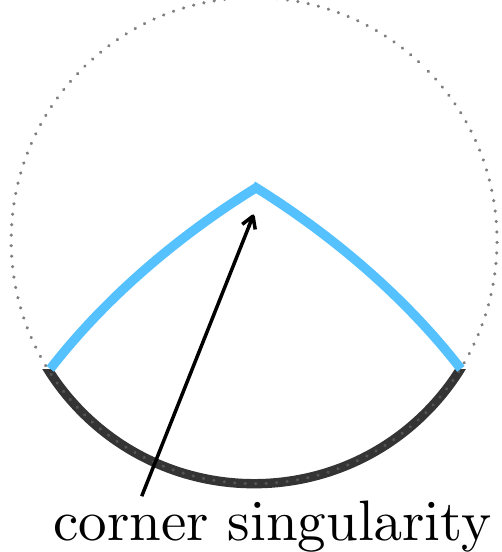
Figure 13 . The holographic dual of a two-point function on a half plane with negative tension. There is a corner defect line on the brane. The tension of the defect is uniquely fixed by the brane tension and the mass of the particle.